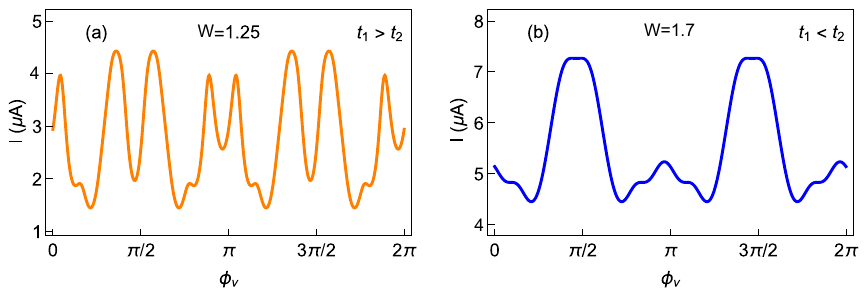
Figure 9. Absolute current at a particular flux φ ( φ = 0.2 ) with respect to the AAH phase factor φ ν for the